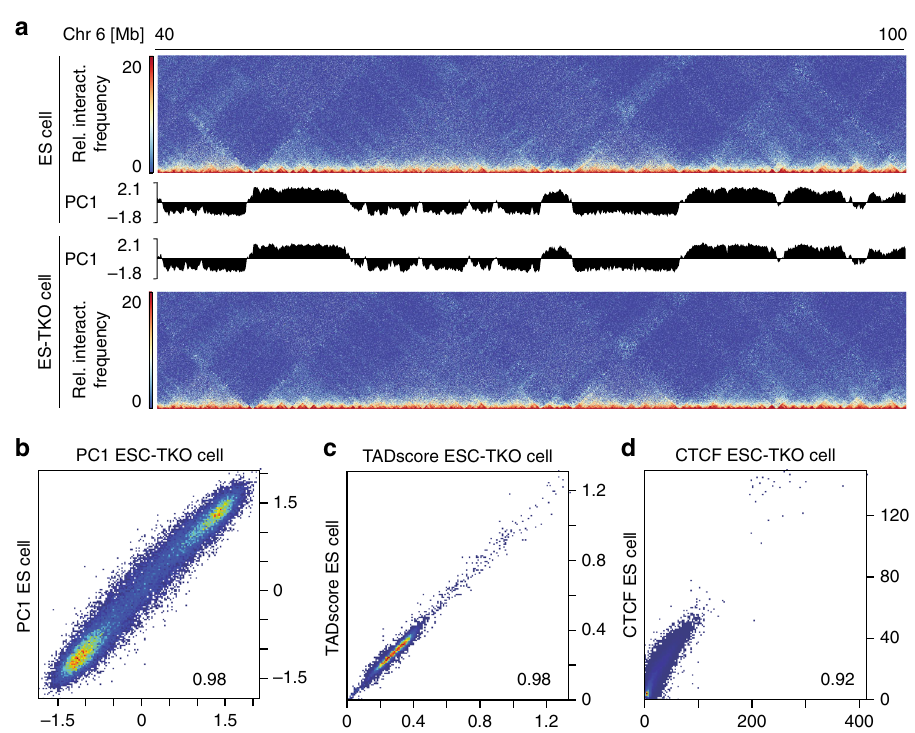
Fig. 4 Loss of DNA methylation does not alter the chromatin organization in mouse ES cells. a Chromatin interaction maps of mouse embryonic stem cells (ES cell line1, upper panel) and ES cells with a complete loss of DNA methylation (ES-TKO cell line 1, Dnmt1 − / − /Dnmt3a − / − /Dnmt3b − / − ) are indistinguishable. b , c Genome-wide correlation show that ablation of DNMT-isoenzymes has no effect of A/B pattern ( b scatter plot and pearson correlation of PC1 values) and insulation of topologically associated domains ( c TADscore). d CTCF peak signals (RPKM) in ES and ES-TKO cells correlates very well suggesting CpG methylation independent CTCF binding. Data shown are merged from n = 2 Hi-C